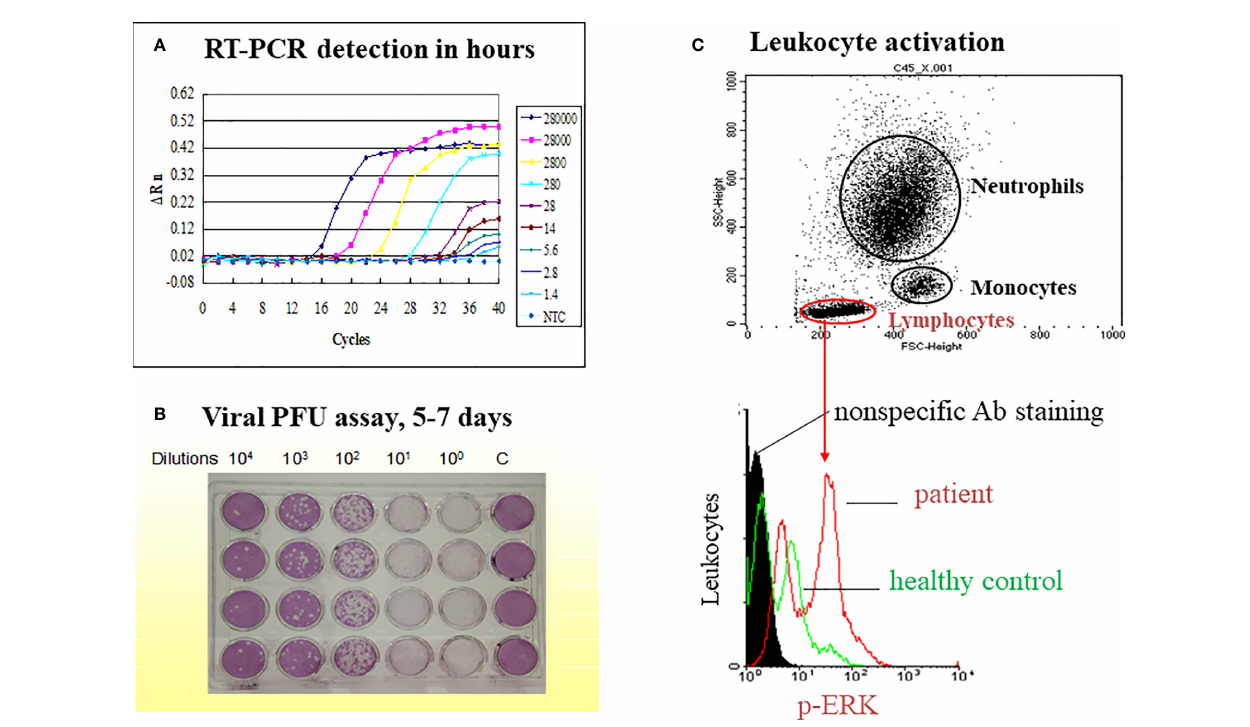
FIGURE 1 | A model on simultaneous measurement of viral load and immune responses in an emerging infectious disease such as dengue fever. The study model presented is derived from our previous publication (Yeh, et al. FEMS Immunol Med Microbiol. 2006;48 (1):84-90). (A) A TaqMan qRT-PCR is used to replace classical time-consuming plaque-forming unit assay of viral load (B) . The limit of detection (LOD) is 14 copies of the dengue 2 virus while cutting off the PCR cycle at 35, and the LOD is 1.4 copies of the dengue virus while cutting off the PCR cycle at 40. (C) A fl ow cytometric assay is used to gate different populations of leukocytes (neutrophil, monocyte and lymphocyte) for the activation assay such as ERK activation in lymphocytes as